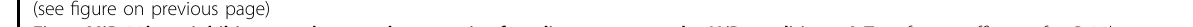
Fig. 4 MiR-20b-5p inhibits autophagy and apoptosis of cardiomyocytes under H/R conditions. A Transfection ef fi cacy of miR-20b-5p mimics and miR-20b-5p inhibitors in cardiomyocytes. B Western blot showed the effect of transfection of miR-20b-5p mimics and miR-20b-5p inhibitors on the expression of LC3II and P62 in normal cardiomyocytes. n = 3. C Western blot showed the effect of transfection of miR-20b-5p mimics and miR- 20b-5p inhibitors on the expression of apoptosis-related proteins, including procaspase-3, cleaved caspase-3, Bax, and Bcl-2 in normal cardiomyocytes. n = 3. D Western blot showed the effects of miR-20b-5p mimics and miR-20b-5p inhibitor transfection on the expression of LC3II and P62 in cardiomyocytes under H/R conditions. n = 3. E Annexin V-FITC/PI fl ow cytometry was used to evaluate the effect of miR-20b-5p mimics and miR-20b-5p inhibitors on cardiomyocyte apoptosis under H/R conditions. n = 3. F Western blot analyzed the expression of apoptosis-related proteins, including procaspase-3, cleaved caspase-3, Bax, and Bcl-2 in cardiomyocytes under H/R conditions by miR-20b-5p mimics and miR-20b-5p inhibitors transfection. n = 3. * P < 0.05 compared with the mimics-NC (MNC) group. # P < 0.05 compared with the inhibitors-NC (INC)